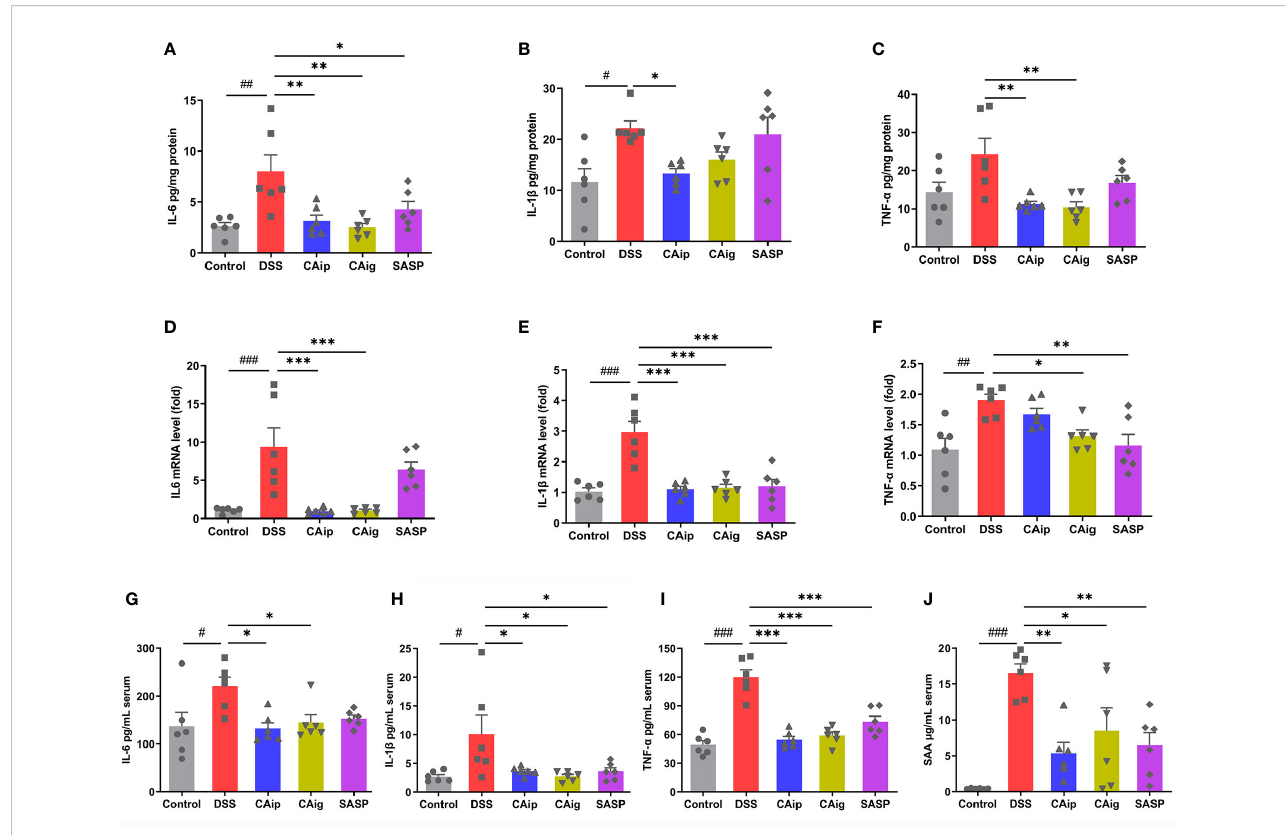
FIGURE 3 Effects of CA on in fl ammatory cytokines IL-6 (A) , IL-1 b (B) and TNF- a (C) by ELISA and mRNA expression of IL-6 (D) , IL-1 b (E) and TNF- a (F) by qRT-PCR in colon tissue. Effects of CA on in fl ammatory markers IL-6 (G) , IL-1 b (H) , TNF- a (I) and SAA (J) in serum by ELISA. Data are expressed as the mean ±